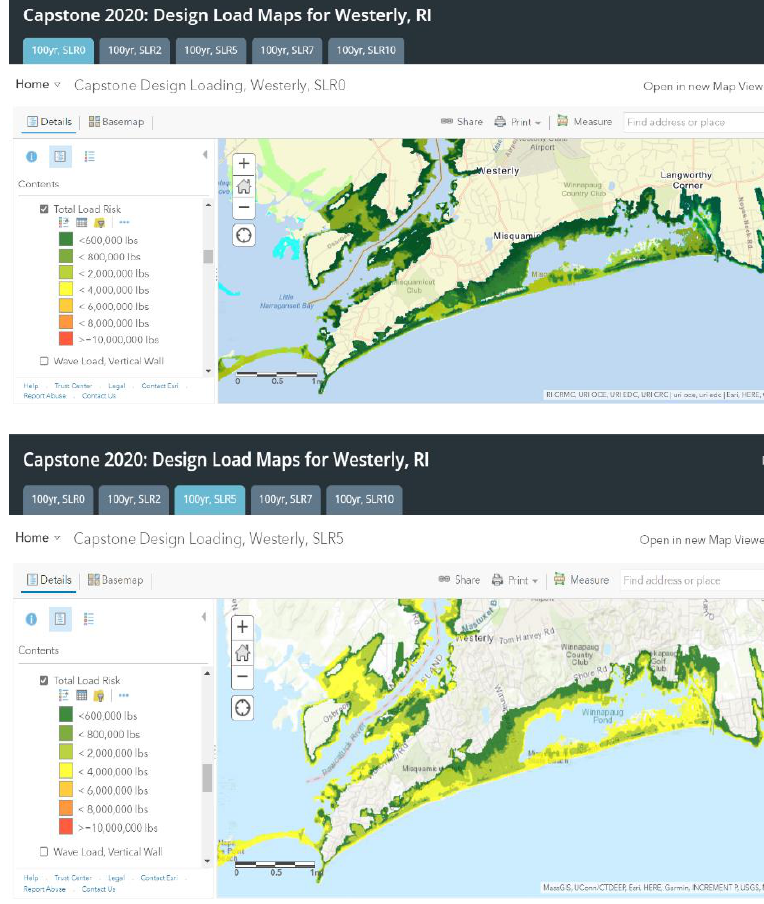
Figure 13. Total load risk (lbs/ft), 100 yr storm, no sea level rise (SLR) ( upper panel) and 5 ft SLR ( lower panel).